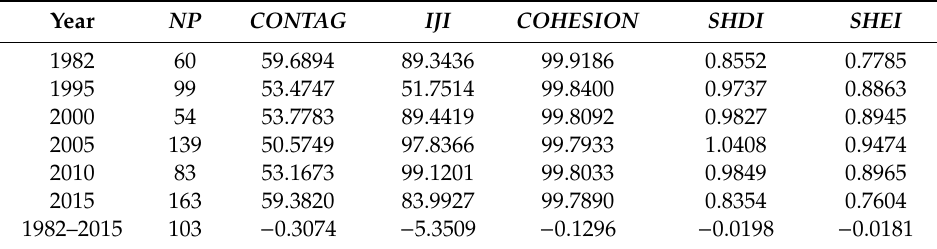
Table 9. Landscape-level indices for the three landscape types together in the Xingkai Lake